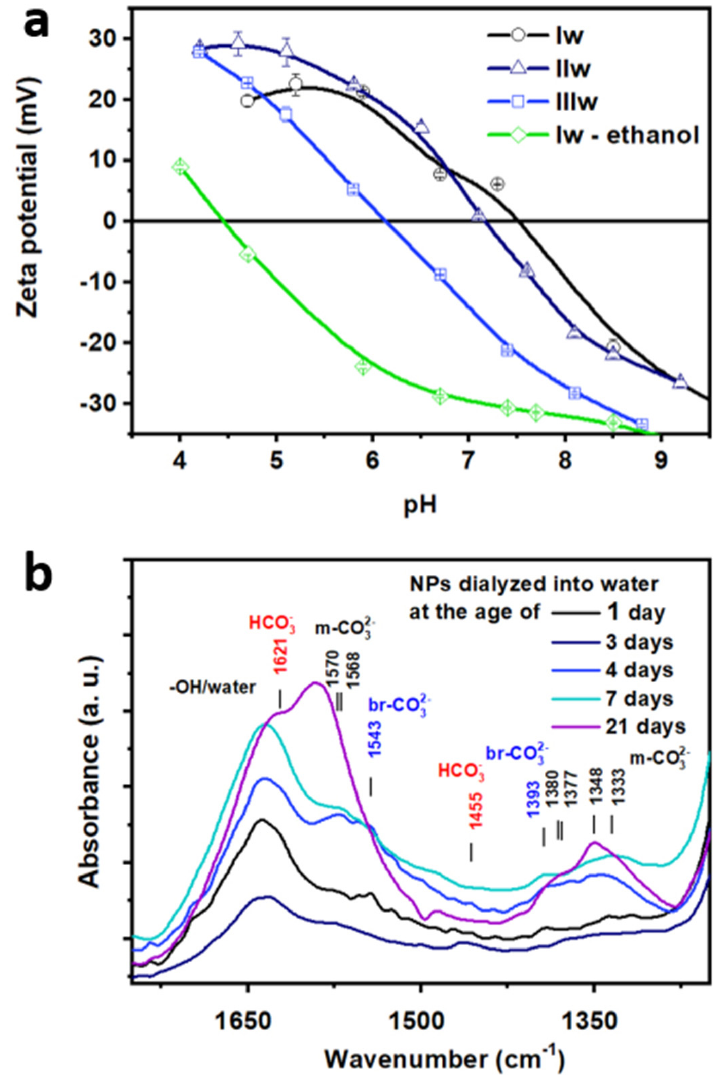
Figure 4. Zeta potential vs. pH curves ( a ) and FTIR spectra ( b ) and of SZ3 (50 nm diameter) NPs after dialysis into the water at different ages: Iw (1 day), IIw (7 days), IIIw (21 days) and Iw-ethanol (freshly dialyzed against ethanol and then against water). The zeta potential measurements show that the IEP of zirconia is continuously decreasing with time, which will affect the colloidal stability and the adsorption properties of the nanocarrier. The FTIR results reveal that the difference in the surface chemistry of samples transferred into water at different ages is